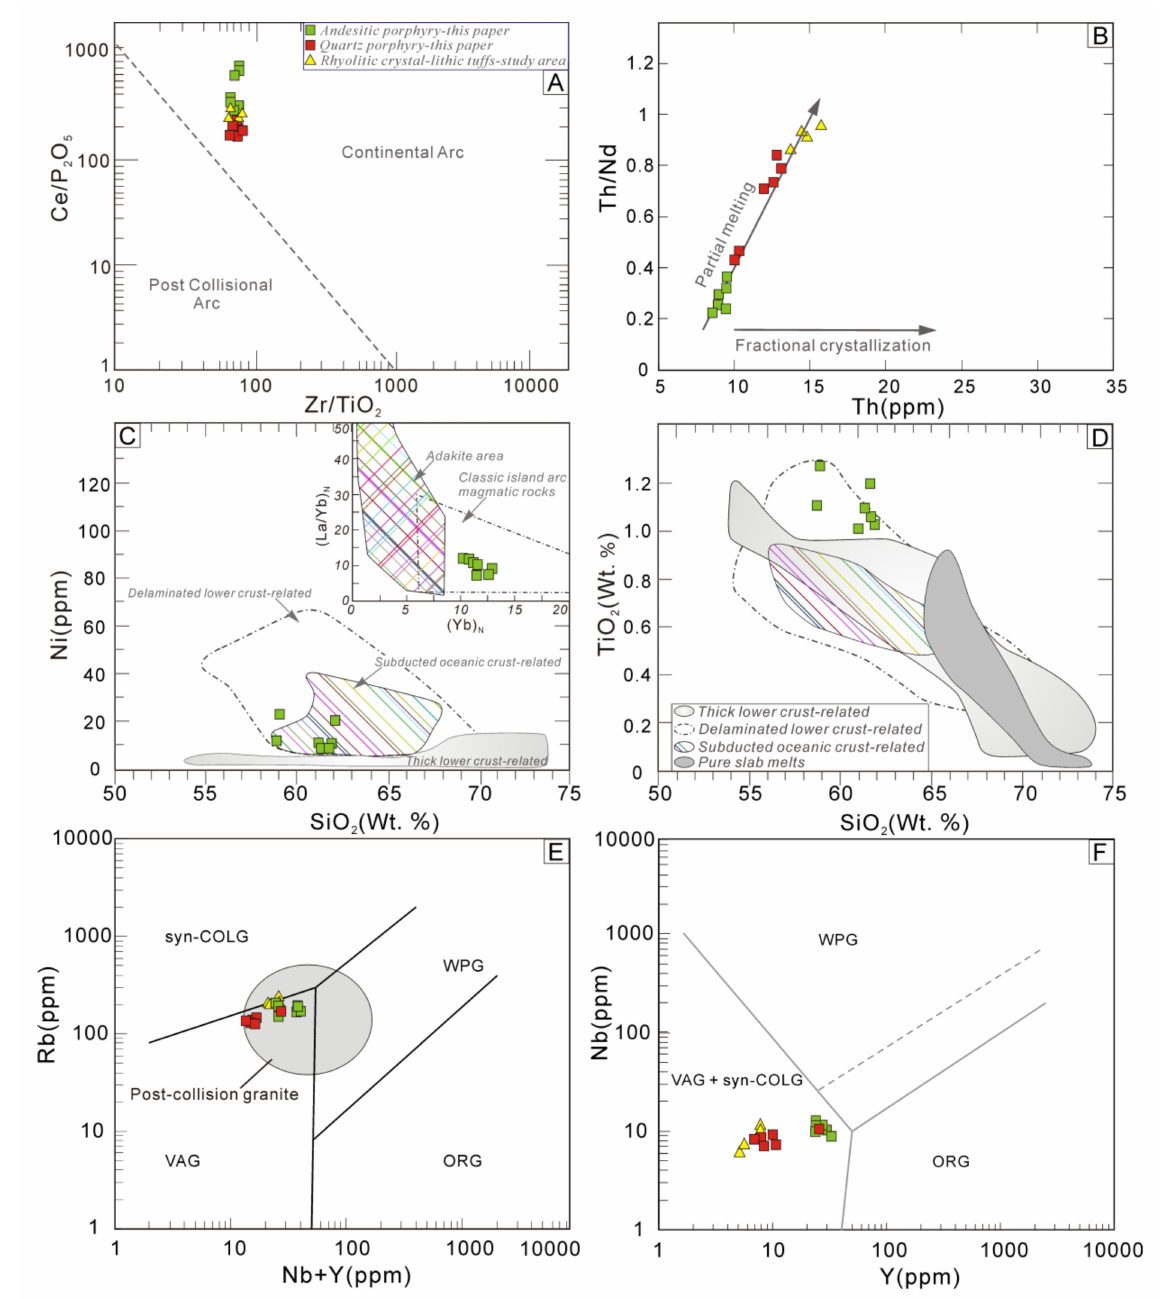
Figure 10. ( A ) Ce / P 2 O 5 vs. Zr / TiO 2 diagram [118]. ( B ) Th vs. Th / Nd diagram [119,120]. ( C ) SiO 2 vs. Ni diagram [74]. ( D ) SiO 2 vs. TiO 2 diagram [74]. ( E ) Rb vs. Nb + Yb diagram. ( F ) Nb vs. Y plot [121,122]. Other data are from